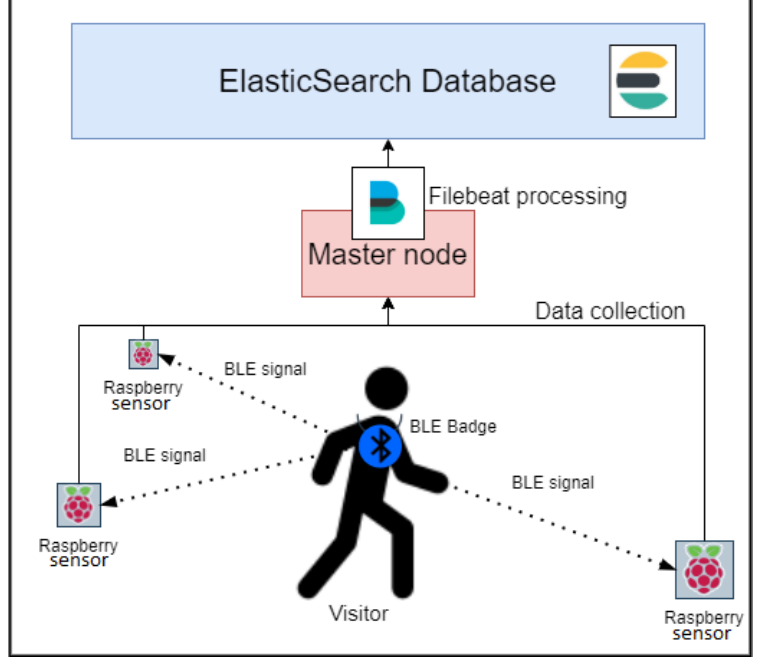
Figure 1. Data collection